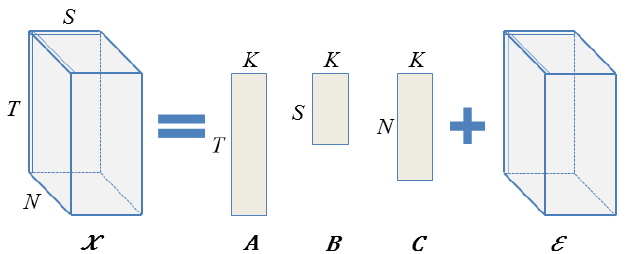
Figure 1. Tensor data representation and its matrix